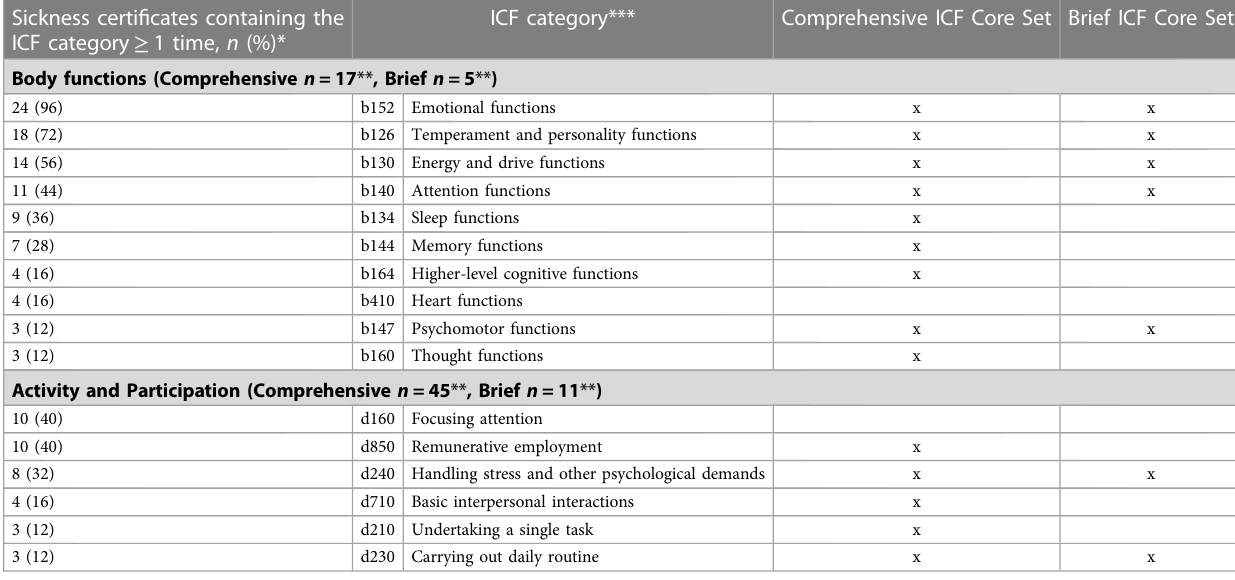
TABLE 3 ICF categories derived from sick leave certi fi cates issued for depression, ranked after relative frequency, and mapped to comprehensive and brief ICF core sets for depression. . Sickness certi fi cates containing the